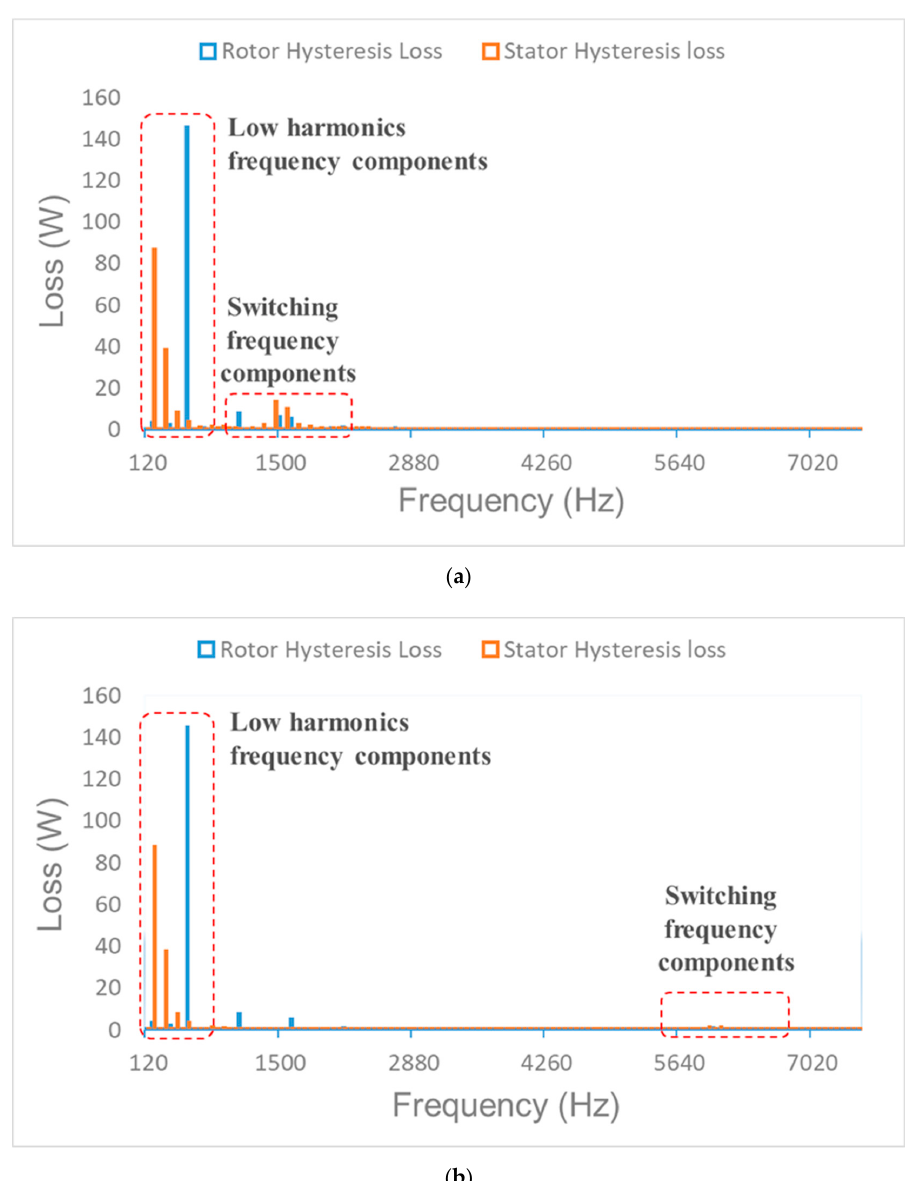
Figure 14. The hysteresis losses of IPMSM in frequency domain at 1200 r / m: ( a ) f sw is 750 Hz; ( b ) f sw is 3000